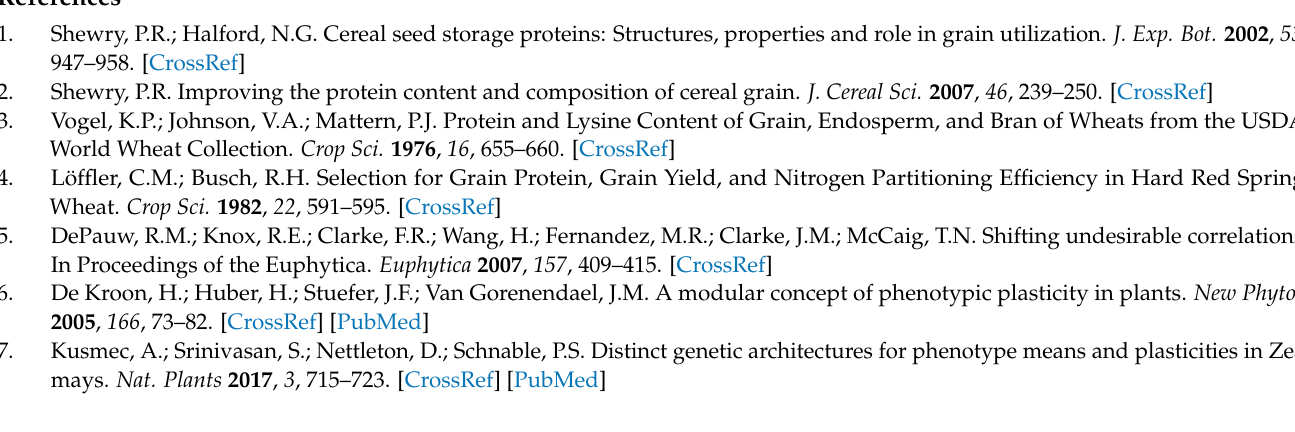
Figure S3: Population structure inferred from principal component analysis and illustrated with the first three principal component’s; Supplementary Figure S4: Manhattan plot representing the position of significant markers controlling the grain protein content stability. The threshold used for the significant association is a Bonferroni correction of 0.05 (A). Quantile-Quantile (Q-Q) plot of marker-trait association study using different principal components as a covariate in the BLINK model for grain protein content stability (B); Supplementary Figure S5: Manhattan plot representing the position of significant markers controlling the grain protein content. The threshold used for significant association is a Bonferroni correction of 0.05 (A). Quantile-Quantile (Q-Q) plot of marker- trait association study using different principal components as a covariate in the BLINK model for grain protein content (B); Supplementary Figure S6: Linkage disequilibrium analysis on the population using complete set of the marker